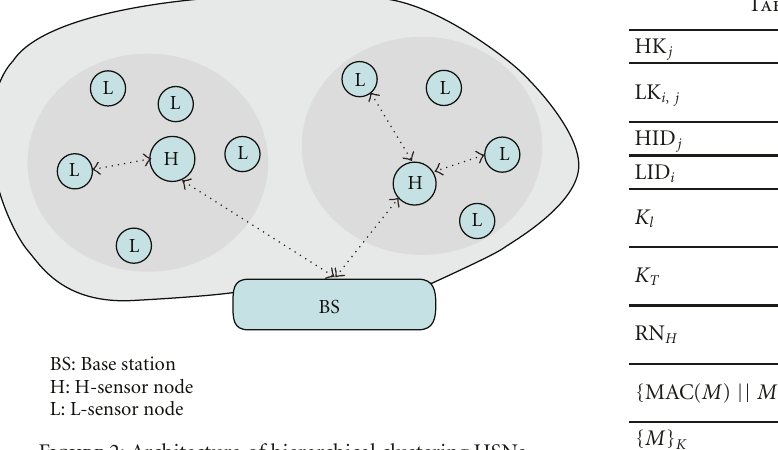
Figure 2: Architecture of hierarchical clustering HSNs.